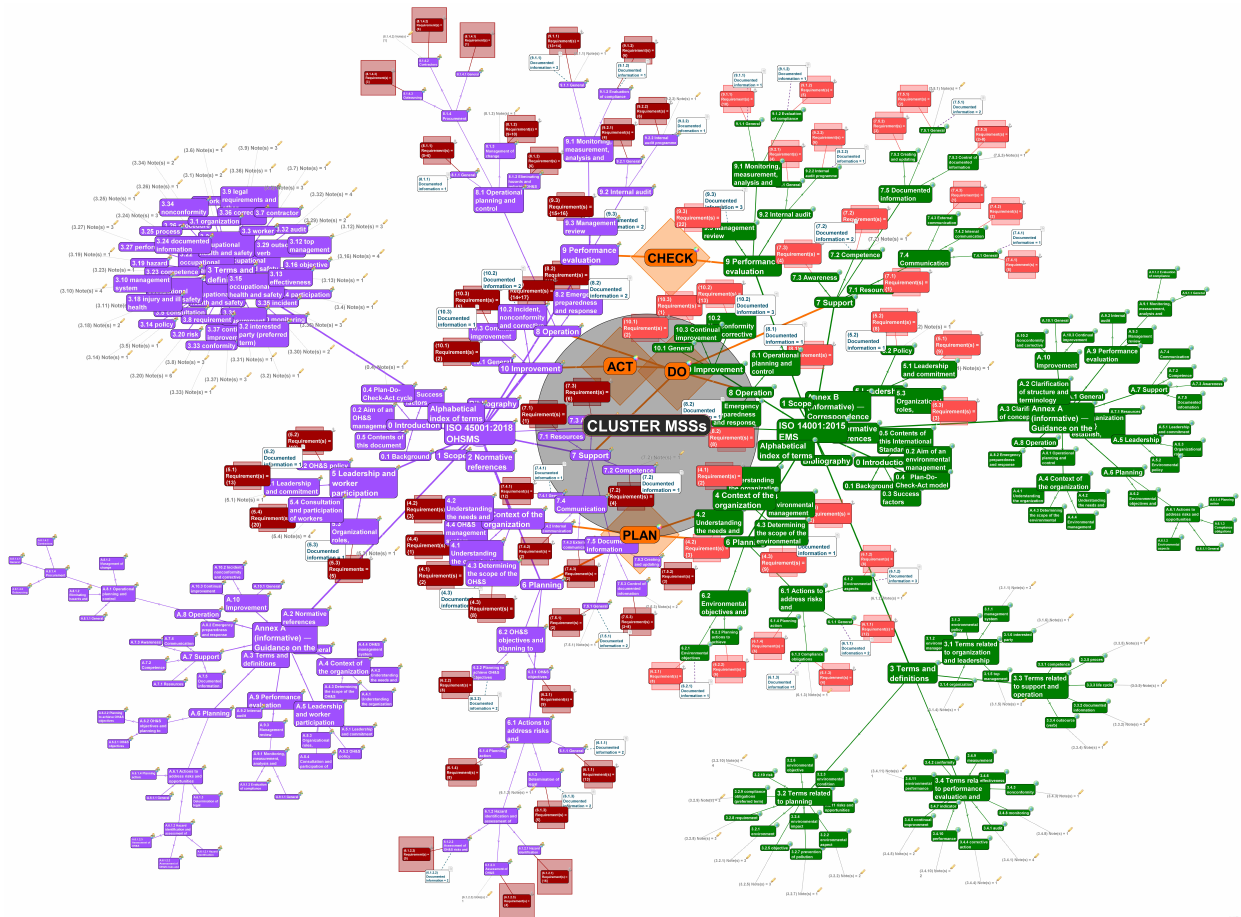
Figure 4. Complex visualized double cluster for EMS and OHSMS with the affiliated requirements, documented information, and notes (source: